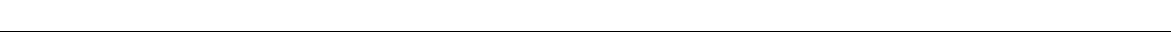
Fig. 4 Acarbose treatment affects the potential for secondary bile acid metabolism. a Comparison of the relative abundances of genes encoding enzymes involved in SBA metabolism exhibiting signi fi cant alterations in abundance after Acarbose treatment, but not after Glipizide treatment; Plotted boxes are interquartile ranges. Dark lines in the boxes indicate medians, the lowest and highest values within 1.5 times IQR from the fi rst and third quartiles,